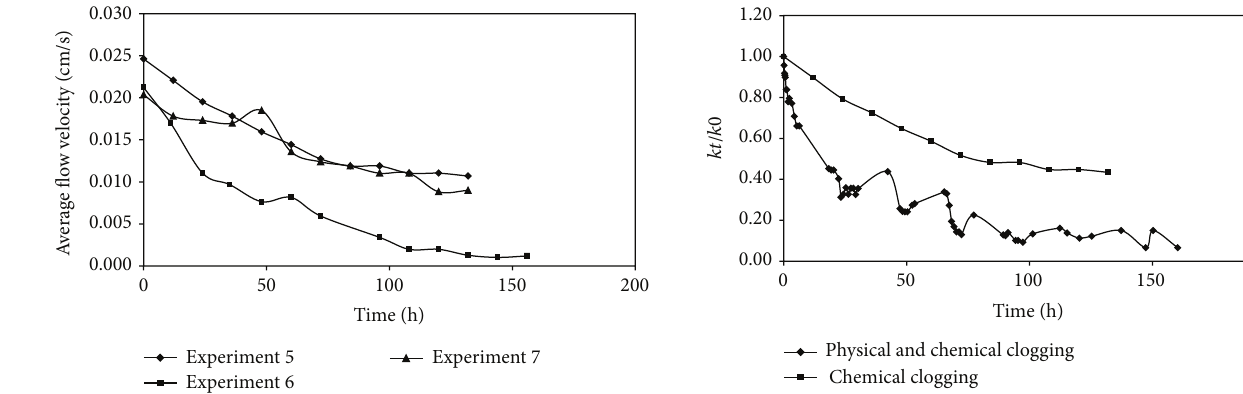
Figure 17: Relationship between 𝑘𝑡/𝑘0 and time in the lowest layers in physical and chemical